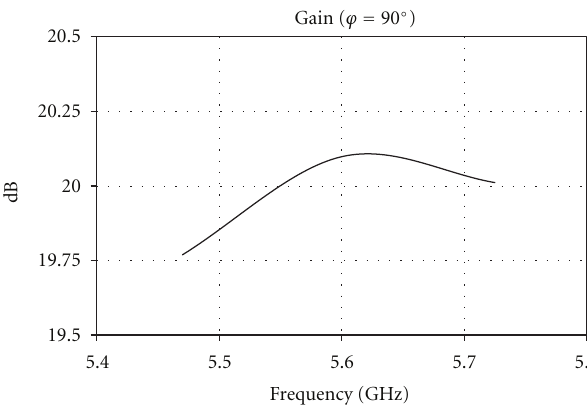
Figure 17: Gain versus the frequency ( θ = 75 ◦ , ϕ = 90 ◦ ).